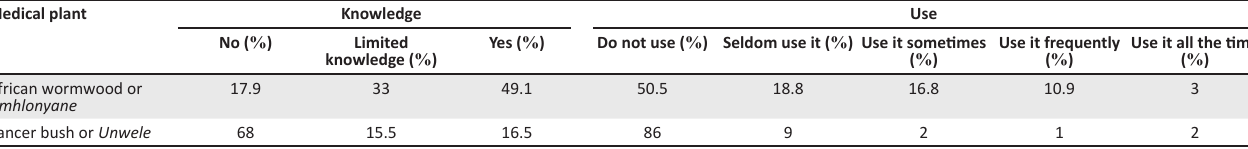
TABLE 2: Knowledge and use of African wormwood and Cancer bush. Medical